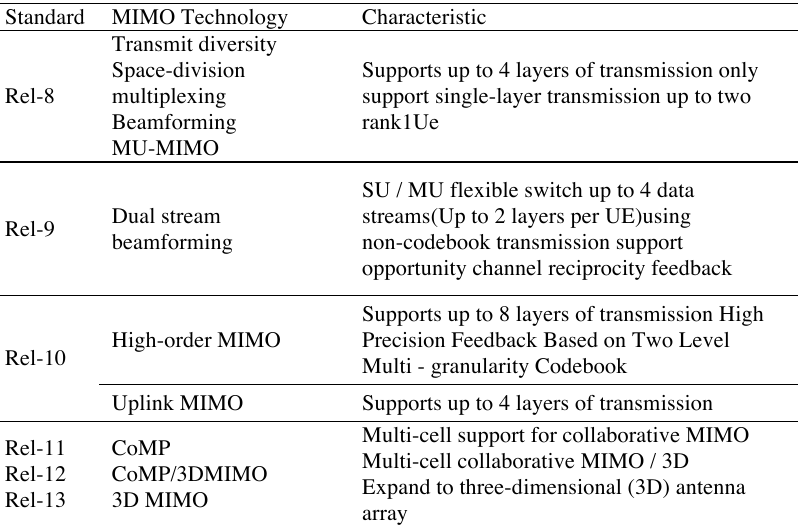
Table 1. MIMO technology standardization